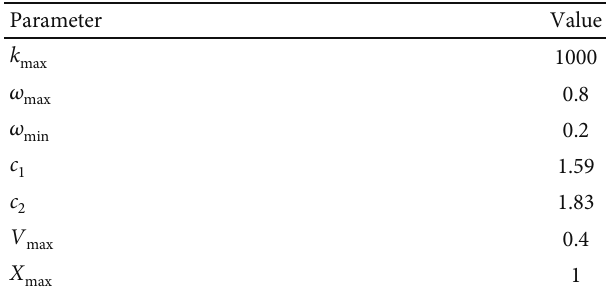
Table 1: Parameter setting of